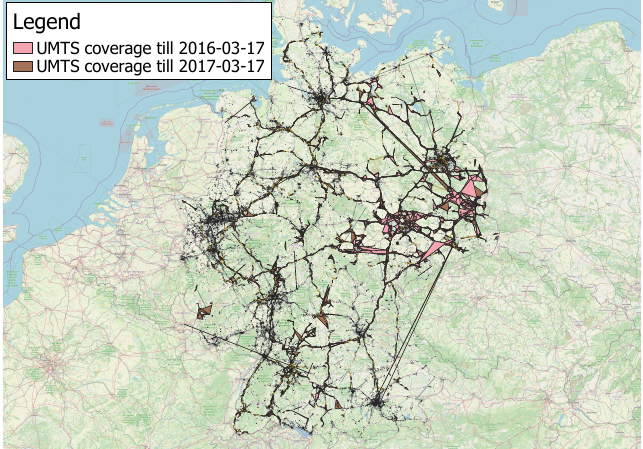
Figure 19. Temporal evolution of the UMTS coverage in Germany: measurements were obtained from 2015 to 03-17 to 2016-03-17 (pink color) or 2017-03-17 (brown color). Only serving cells are